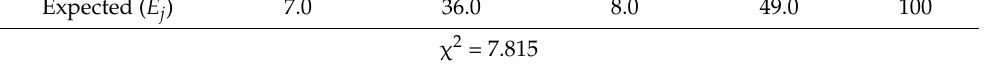
Table 1. Verification of χ 2 test of homogeneity.